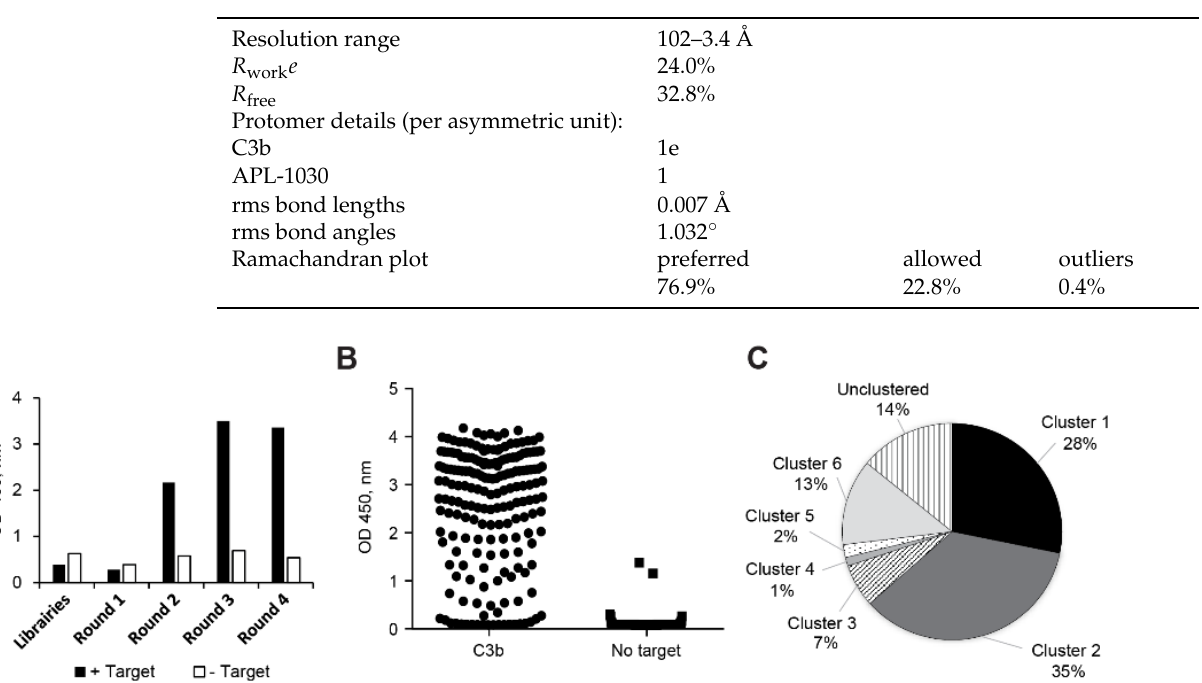
Table A3. Crystal structure refinement statistics.